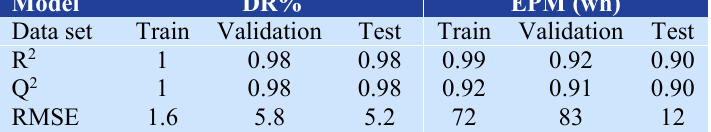
Table 1. Statistical characteristics of both ANN models for DR% and